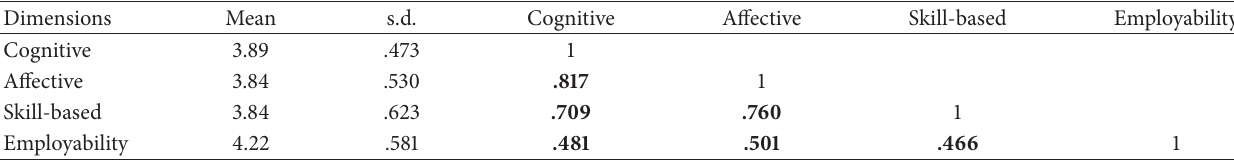
Table 6: Correlation analysis—universities sample.